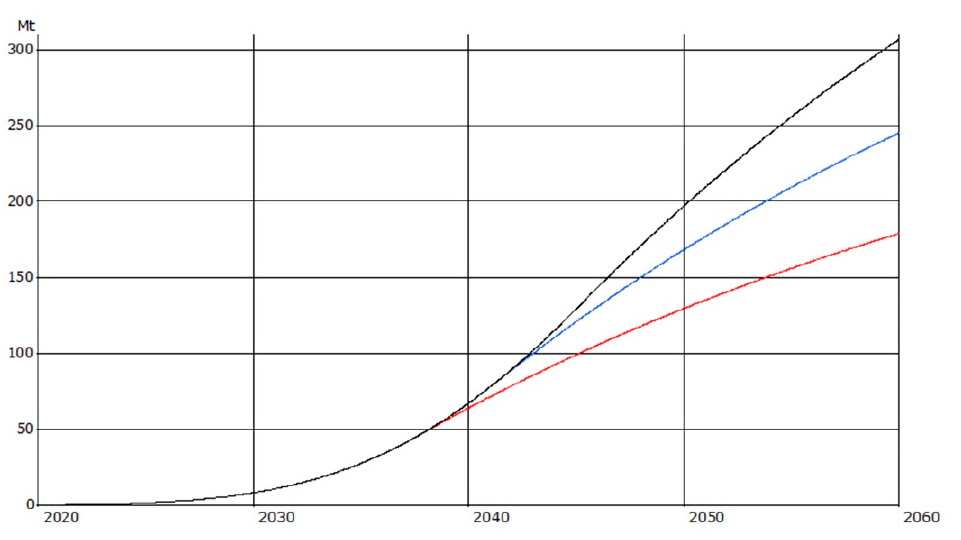
Figure 4. Evolution of ‘saved sand and gravel’ in the different scenarios from 2020 to 2060, measured in mega tons (Mt): Recycling (RC) scenario (red), Secondary Input (SI) scenario (blue), Resource Saving (RS) scenario (black).